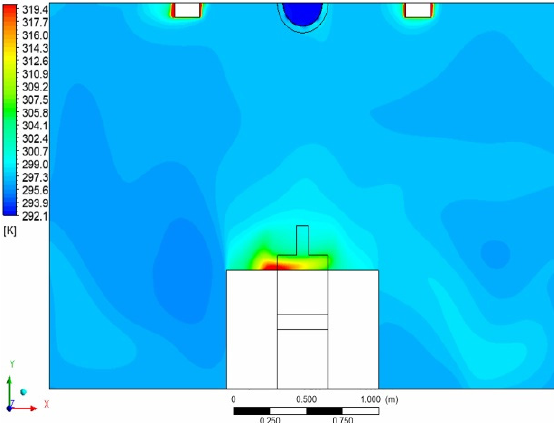
Figure 15. The temperature distribution of the Z = 2 m section.